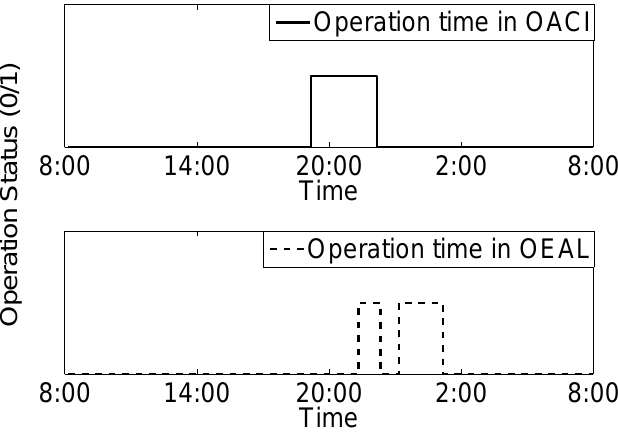
Figure 5. Comparison of the operation time for